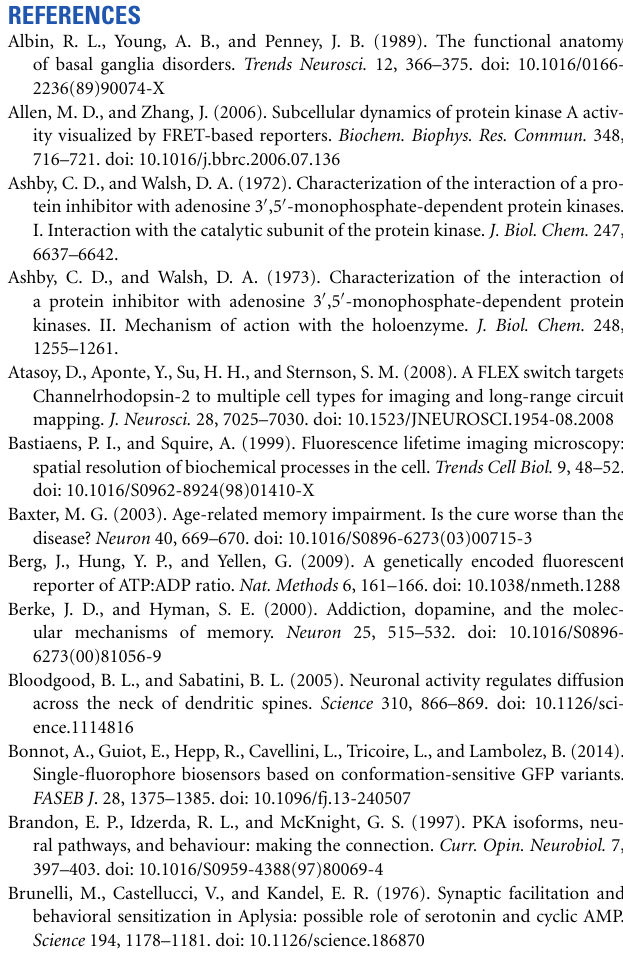
Supplementary Figure 1 | Diagram illustrating how FRET changes fluorescence lifetime. Free donor fluorophores show a single exponential decay of fluorescence lifetime distribution (green). When donor and acceptor fluorophores interact via FRET, an additional decay process occurs, resulting in bi-exponential decay and shorter lifetime (red). P free and P FRET represent the fractions of donors that are free and that have undergone FRET respectively. P free + P FRET = 1. Supplementary Table 1 | Optical characteristics of the three donors and two acceptors used in the 4 PKA reporters. The brightness is relative